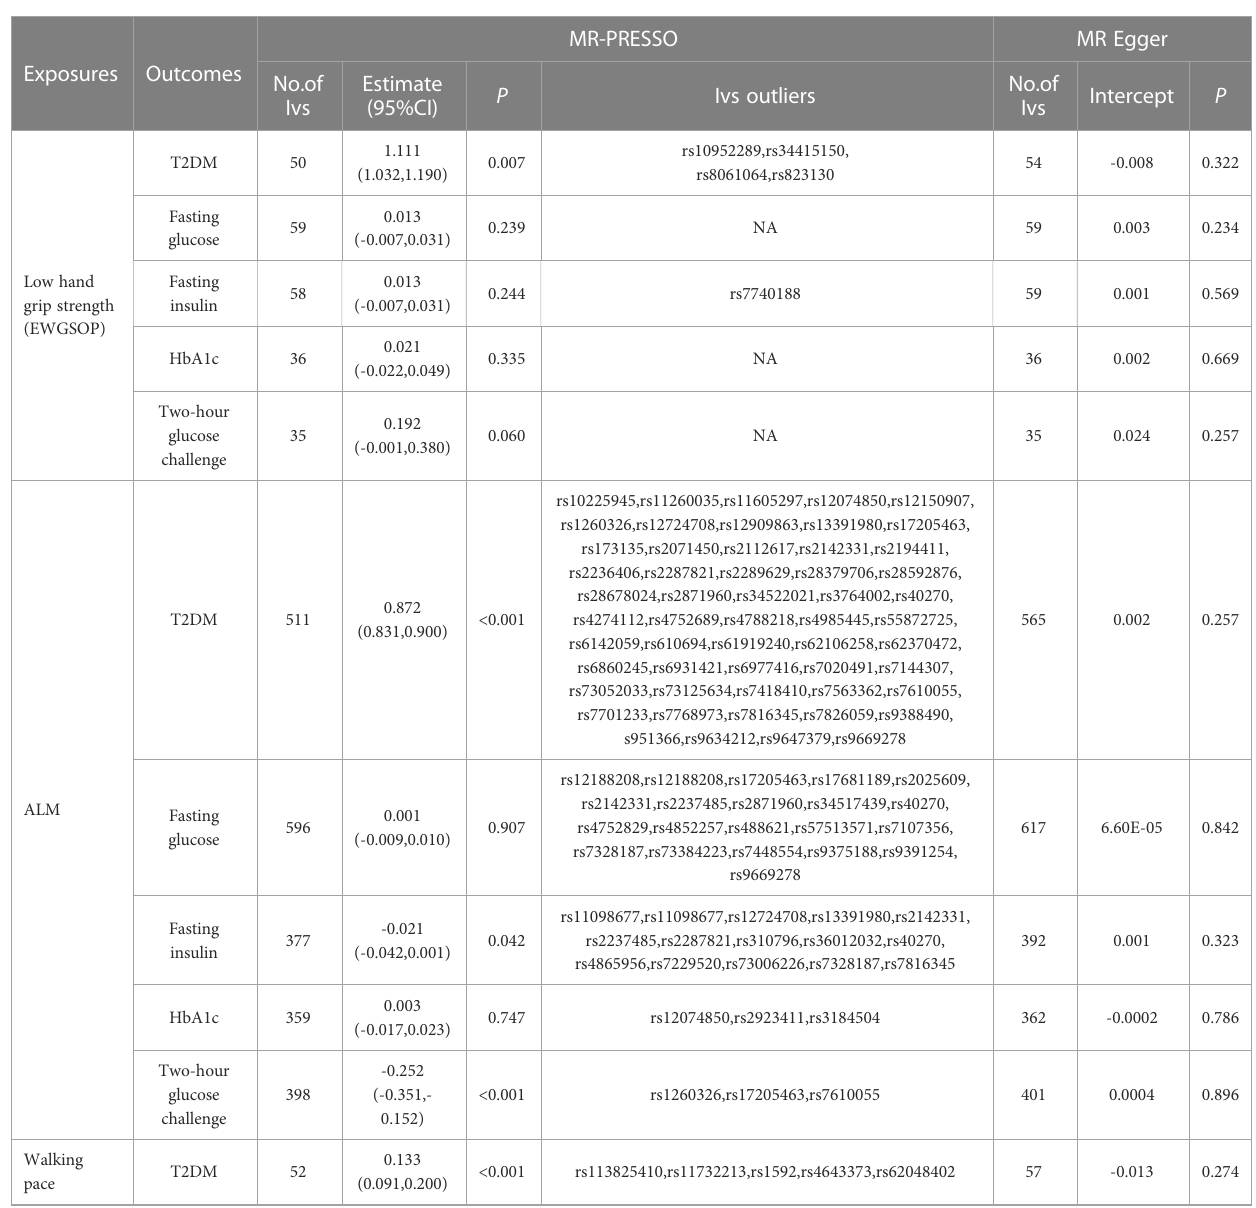
TABLE 4 Association sarcopenia-related traits with T2DM and glycaemic traits using MR-PRESSO and MR